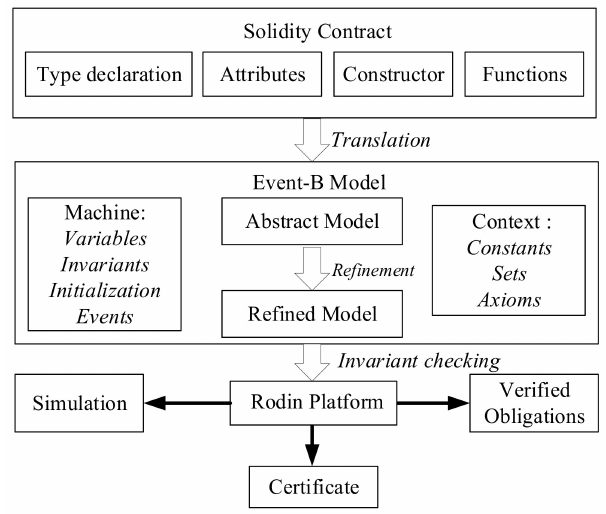
Figure 8. Translation and verification of solidity contracts in Event-B.